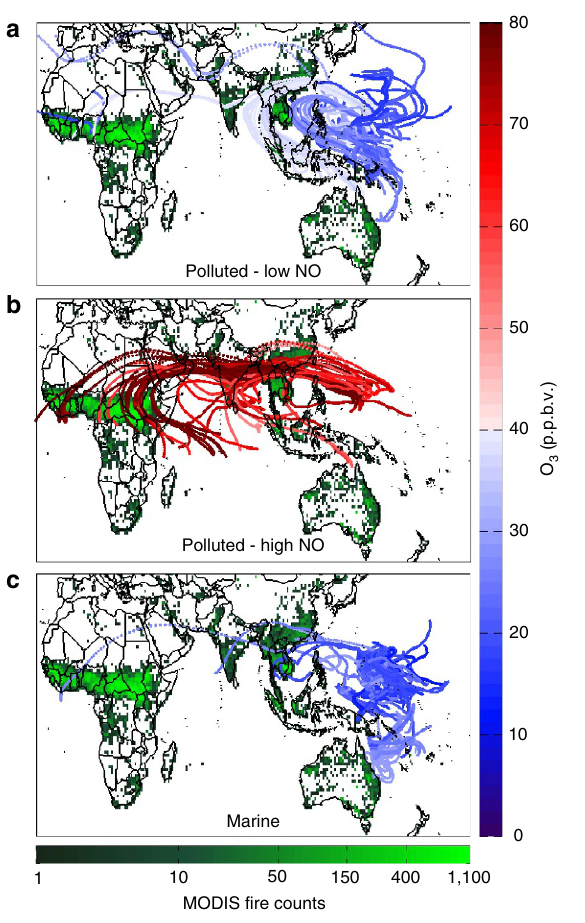
Figure 6 | Back trajectories by chemical regime. 10-day, HYSPLIT back trajectories for all CAST flights analysed here and CONTRAST RF03–05 and RF07–14 for observed pressures between 300 and 700hPa. Trajectories are stopped when encountering convective precipitation and coloured by observed O 3 . Trajectories are separated by the CO regimes illustrated in Supplementary Fig. 2: ( a ) Polluted—low NO (CO 4 95p.p.b.v. and NO o 40p.p.t.v.), ( b ) Polluted—high NO (CO 4 95p.p.b.v. and NO 4 50p.p.t.v.), and ( c ) Marine (CO o 80p.p.b.v. and NO o 30p.p.t.v.). The sum of January and February 2014 MODIS fire counts is shown in green.